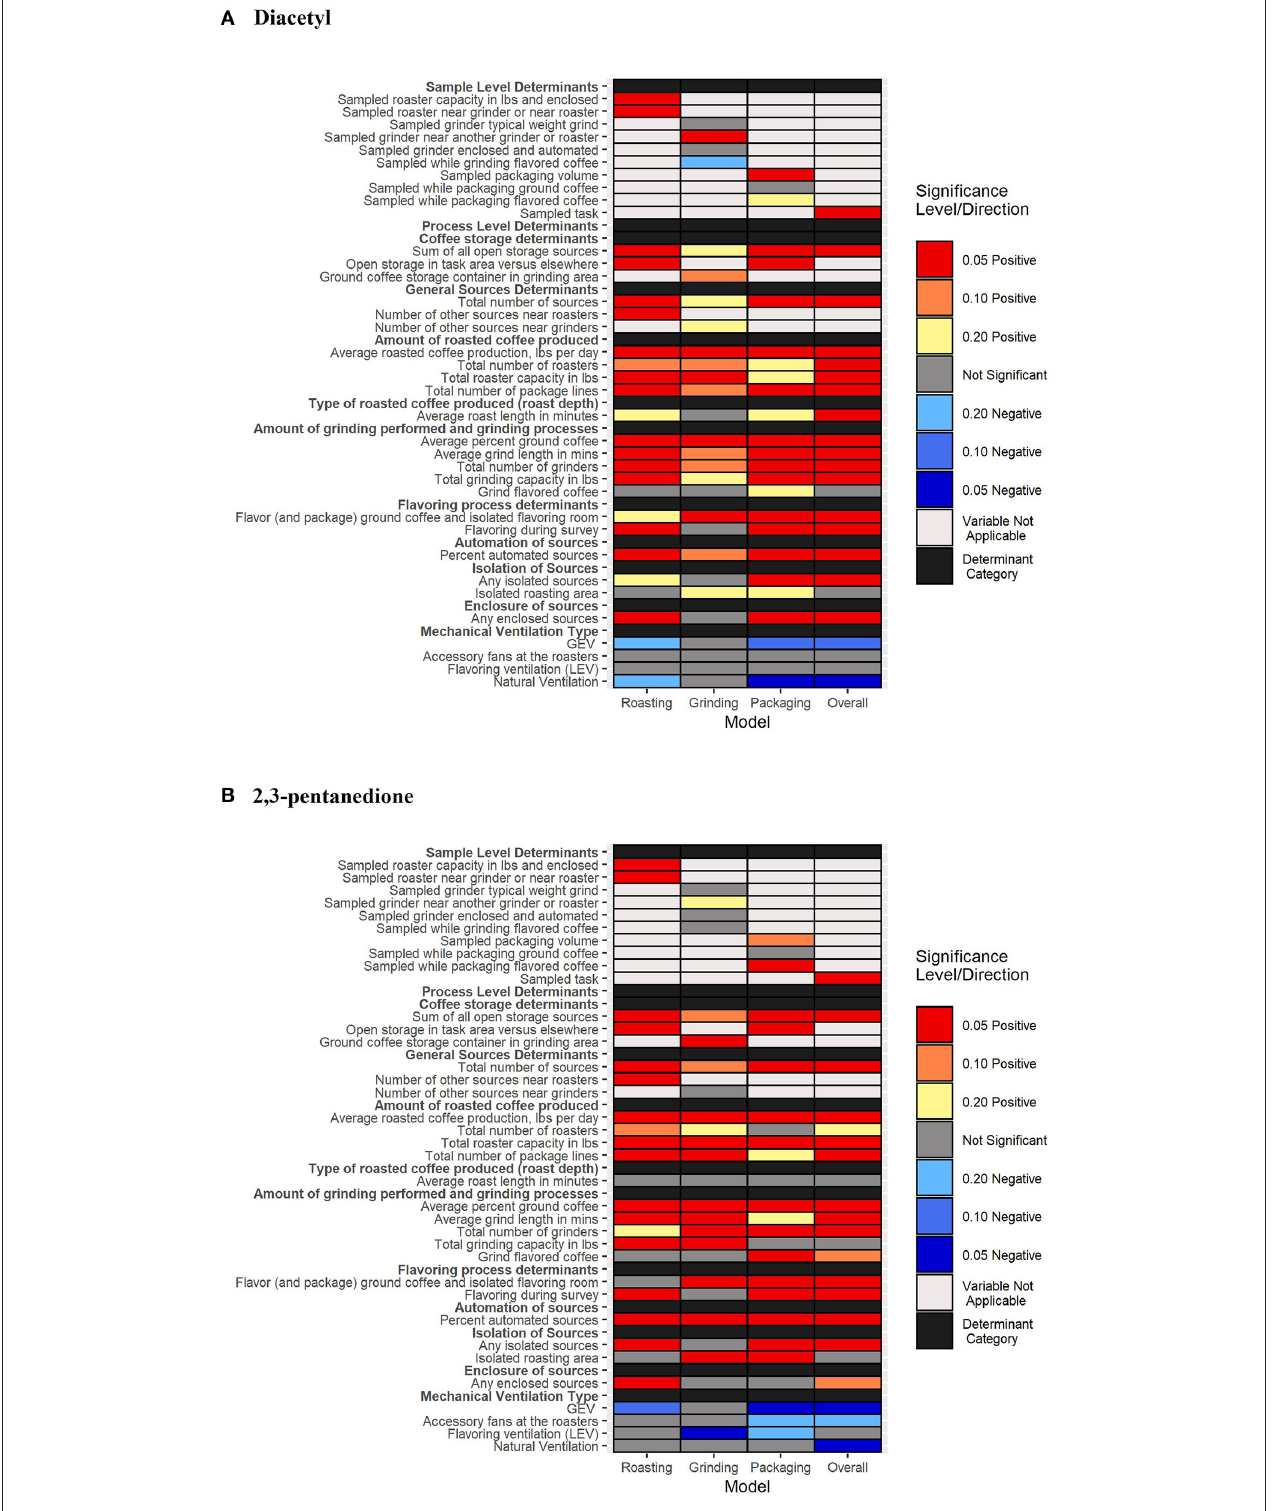
FIGURE 2 | A heat-map of significant determinants identified in univariate analyses considered for models of diacetyl (A) and 2,3-pentanedione (B) exposure. Notable credible intervals (CIs) are depicted for 80, 90, and 95% CIs. Positive associations are depicted with warm colors (yellow, orange, and red) and negative associations are depicted with cool colors (light blue to dark